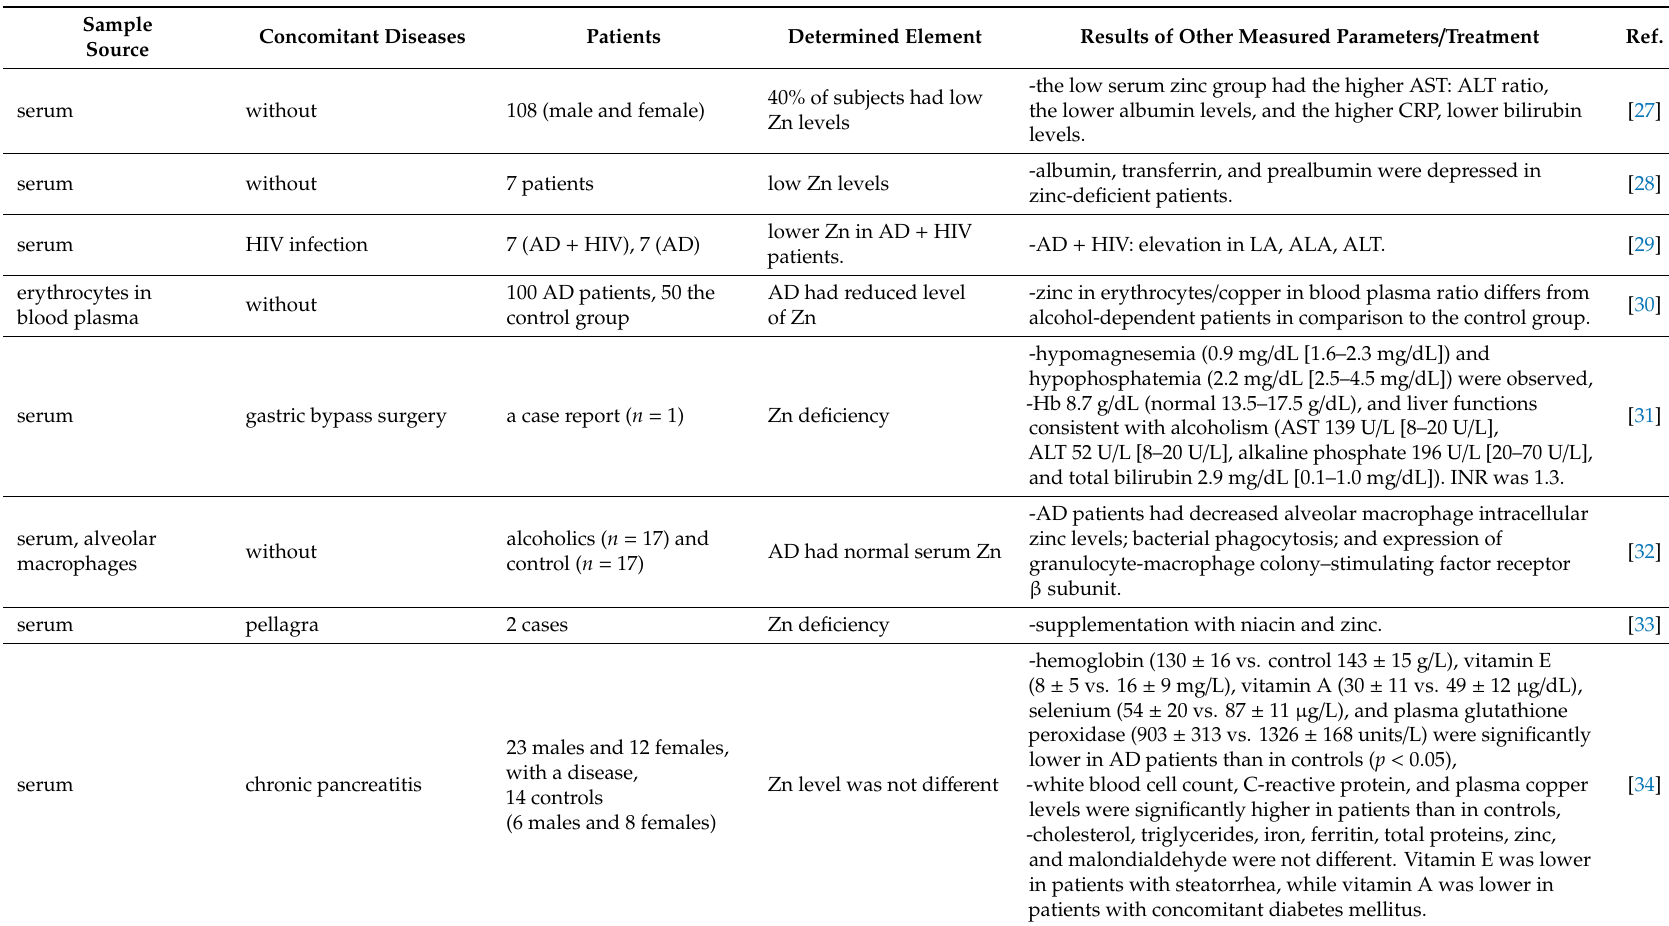
Table 1. Minerals deficiency in patients of alcohol